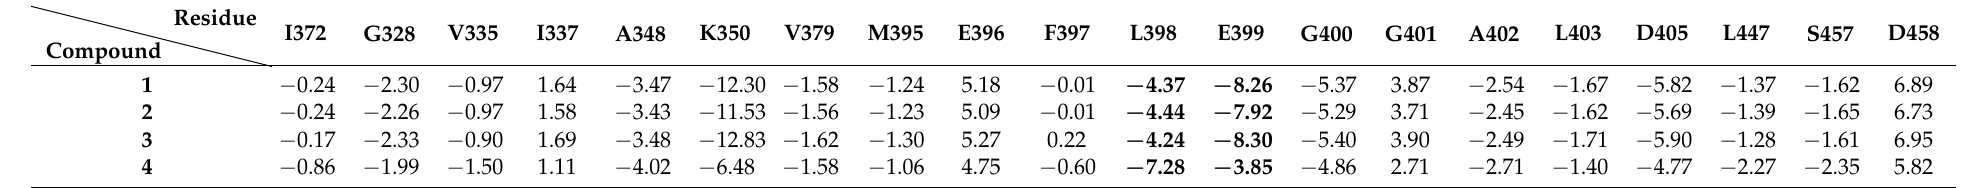
Table 3. Electrostatic energies (E es ) calculated at the FMO-DFTB3/3OB-3-1 level. The Electrostatic energies (E es ) of the hinge regions, L398 and E399, are shown in bold.